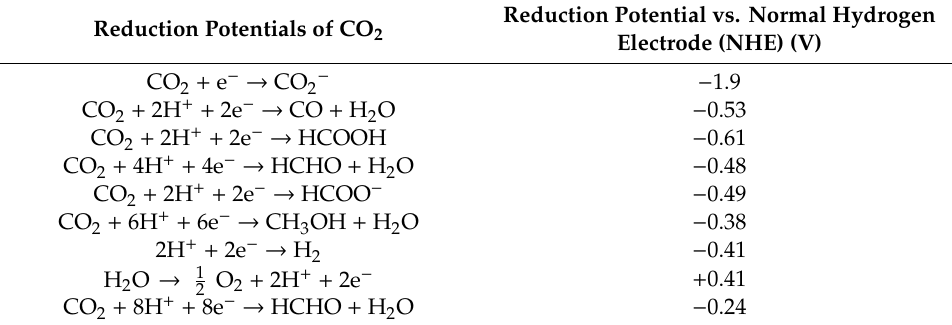
Table 7. [142]: Standard photo-reduction potentials for the CO 2 reduction reaction.